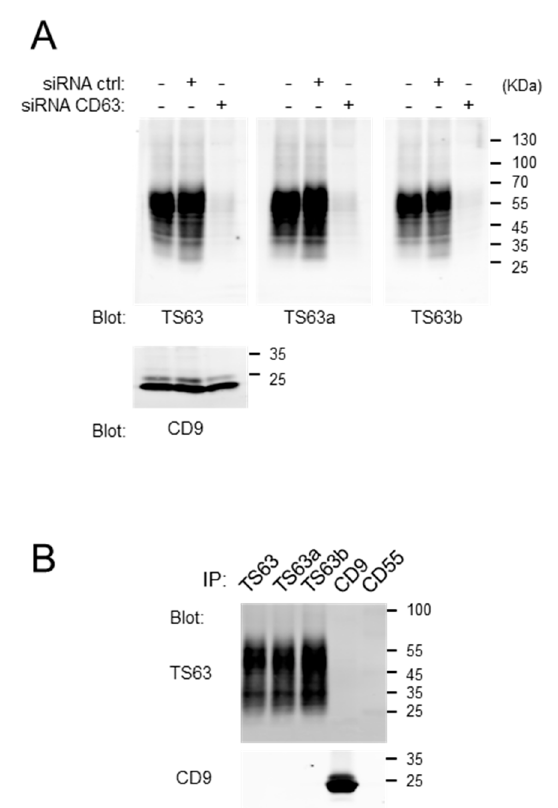
Figure 2. Validation that the TS63 variants recognize CD63. ( A ) Western-blot analysis, using the different TS63 variant or a CD9 mAb as a control, of HeLa cell lysates after treatment or not with a siRNA targeting CD63 or a control siRNA. ( B ) Immunoprecipitations using the different TS63 variants or CD9 and CD55 mAb as a control. The presence of CD63 and CD9 in the immunoprecipitates was analyzed by Western-blot using biotin-labeled TS63 and TS9 mAbs.